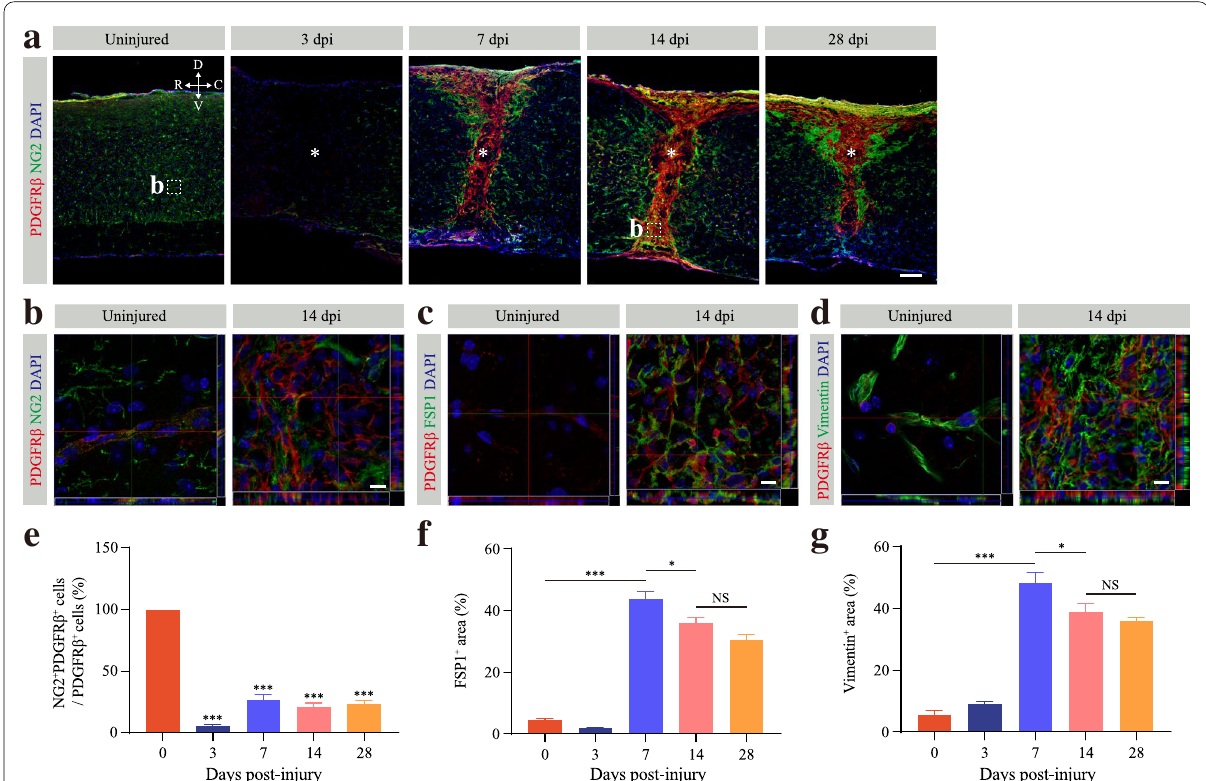
Fig. 2 Pericyte transition into fibroblasts after SCI. a – d Representative immunofluorescence images taken in the spinal cords of uninjured mice and injured mice at 3, 7, 14, and 28 days post‑injury (dpi) showing that fibrotic scarring PDGFRβ + fibroblasts (red) lose the expression of the pericyte marker NG2 (green, a and b ) but robustly express the fibroblast markers FSP1 (green, c ) and vimentin (green, d ) after SCI. The nuclei are stained with DAPI (blue). The high magnification z‑stack images of the dotted area in a are shown below as the region of interest in b. e Quantification of the percentage of NG2 + PDGFRβ + cells out of the total PDGFRβ + cells in the lesion core. f , g Quantification of the percentage of FSP1 + area ( f ) and vimentin + area ( g ). The asterisks indicate the lesion core. Data are shown as mean s.e.m. n 4 mice per time point. Scale bars: 100 μm ( a ) and 10 ± = μm ( b–d ). All images are from sagittal sections. NS, no significance; * p < 0.05, *** p < 0.001 by one‑way ANOVA followed by Tukey’s post hoc test in e , f . 3, 7, 14, and 28 dpi versus 0 dpi in